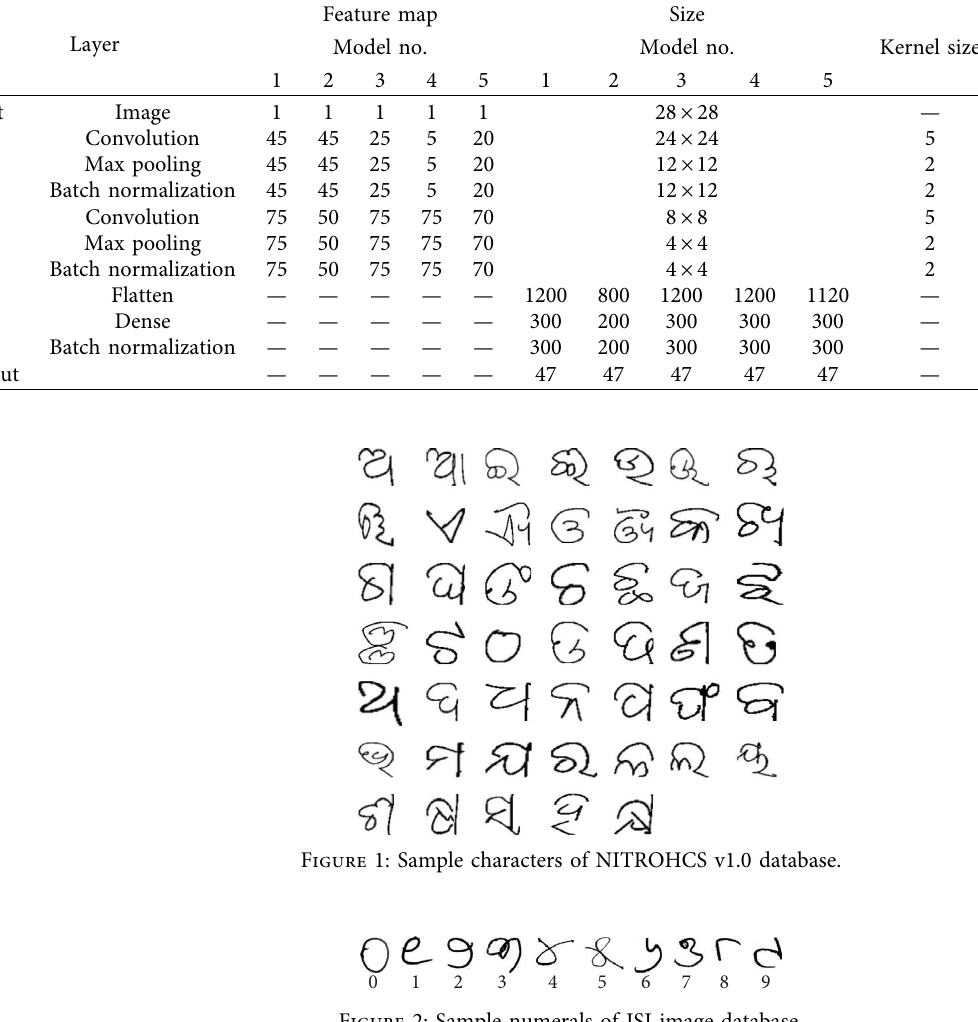
Table 1: Architectural specifcation of the proposed fve CNN models M1, M2, M3, M4, and M5.